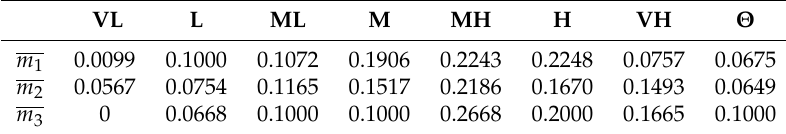
Table 6. The weighted average of evidence of bottom criteria.